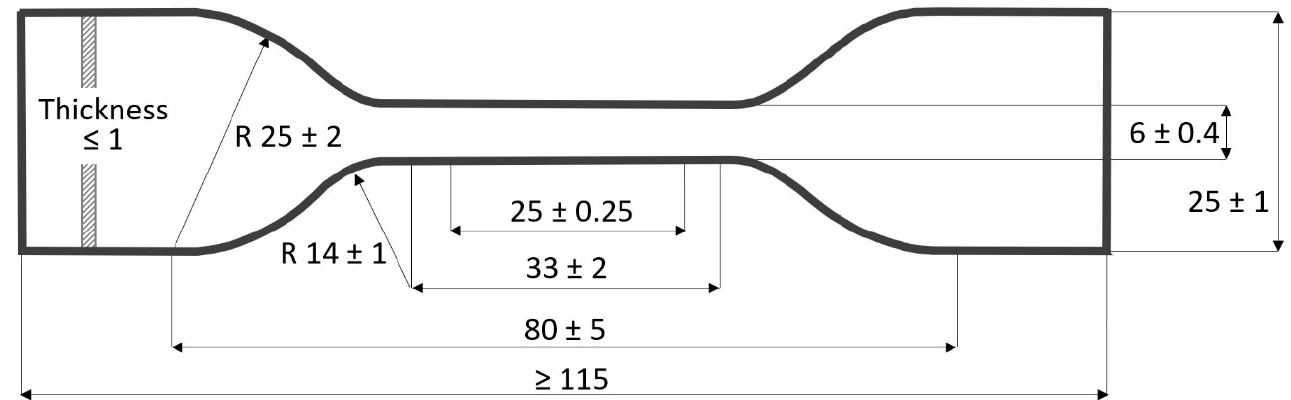
Figure 1. Tensile test specimen (specimen type 5), for non-rigid plastics (measured in mm).